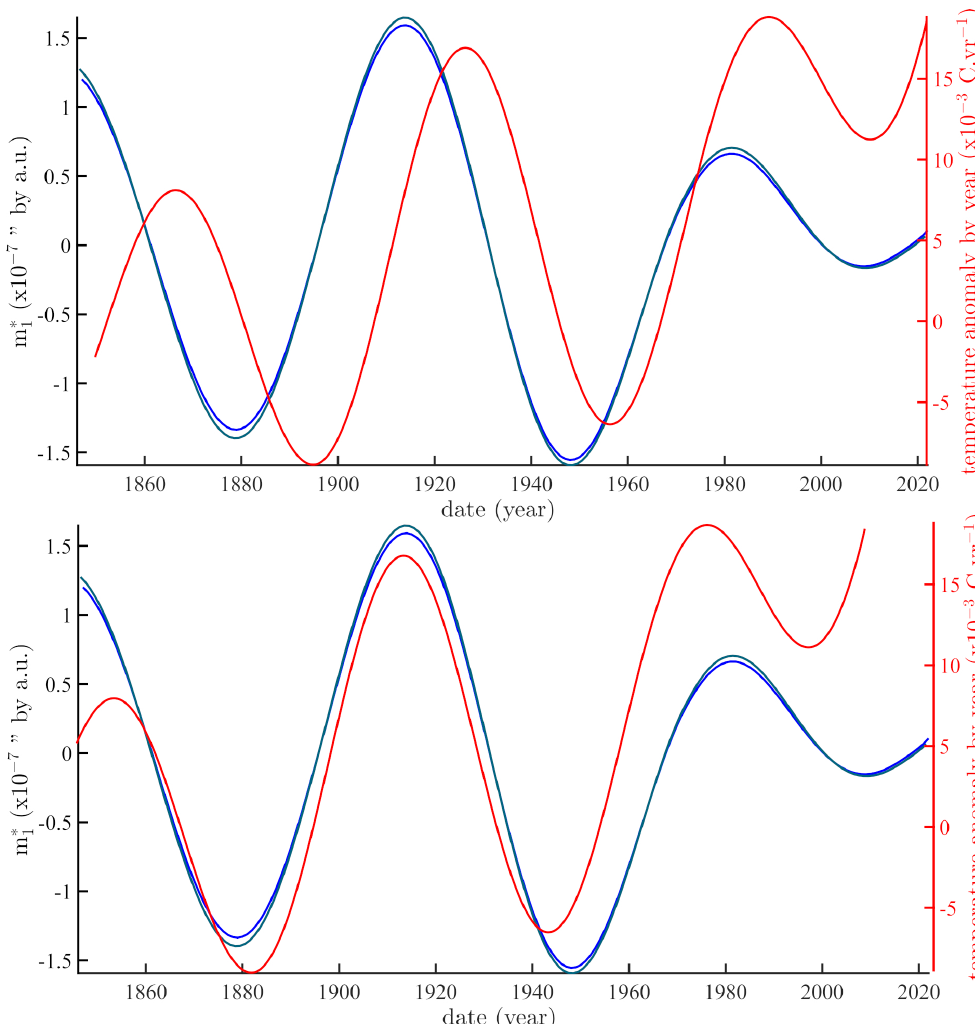
Figure 10. ( top ) In red, the derivative of the iSSA trend of temperature; in green and blue, the inverse square of the drift of solstices. ( bottom ) A phase quadrature has been applied to the solstices curves above, that is a backward translation of 15 year (=60